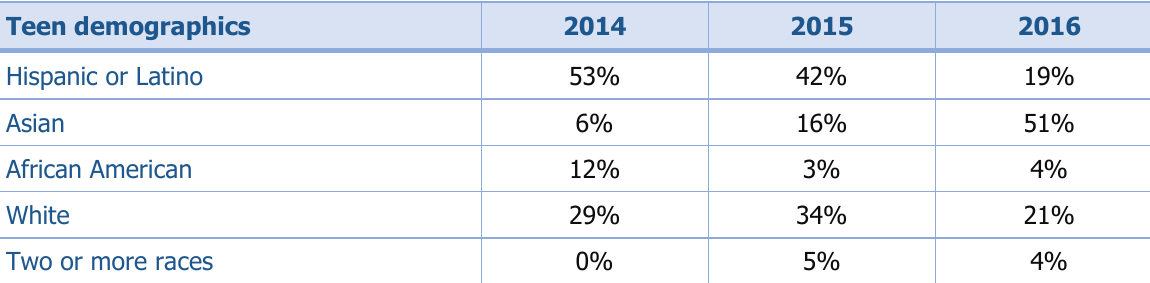
Table 3. Teen Teacher Participant Demographics